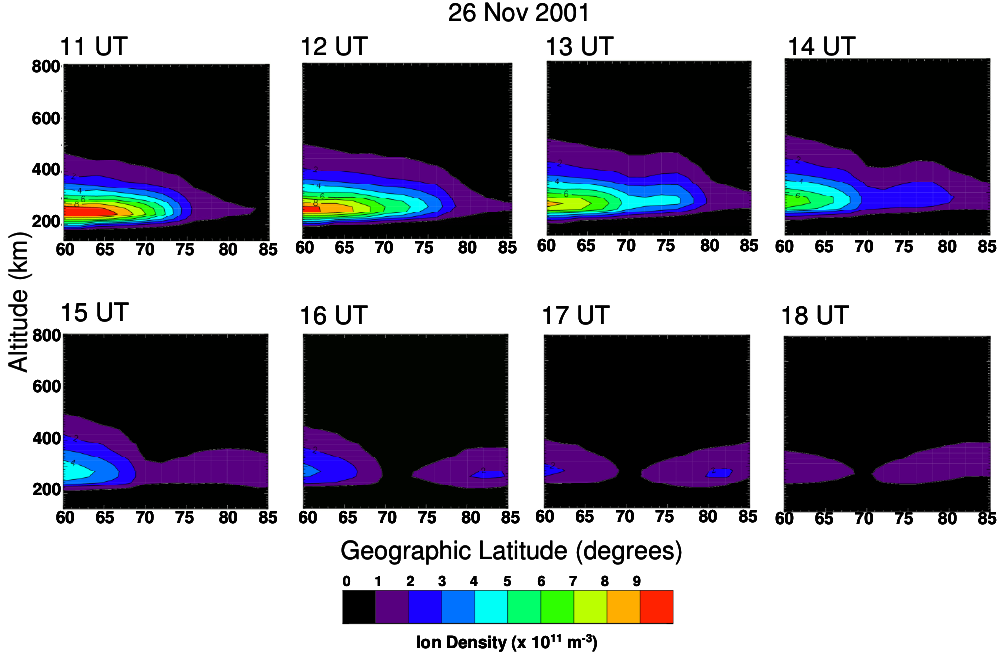
Fig. 13. CTIP modelled ion densities at hourly intervals between 11:00UT and 18:00UT for latitude-versus-altitude planes at the 18 ◦ E Figure 13: CTIP modelled ion densities at hourly intervals between 11UT and 18UT for latitude-versus-altitude planes at the 18ºE meridian.